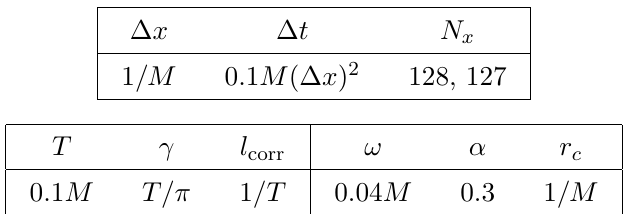
Table 1 . Numerical setup and parameters of the potentials. N x = 128(127) is used for the harmonic (regularized Coulomb) potential.